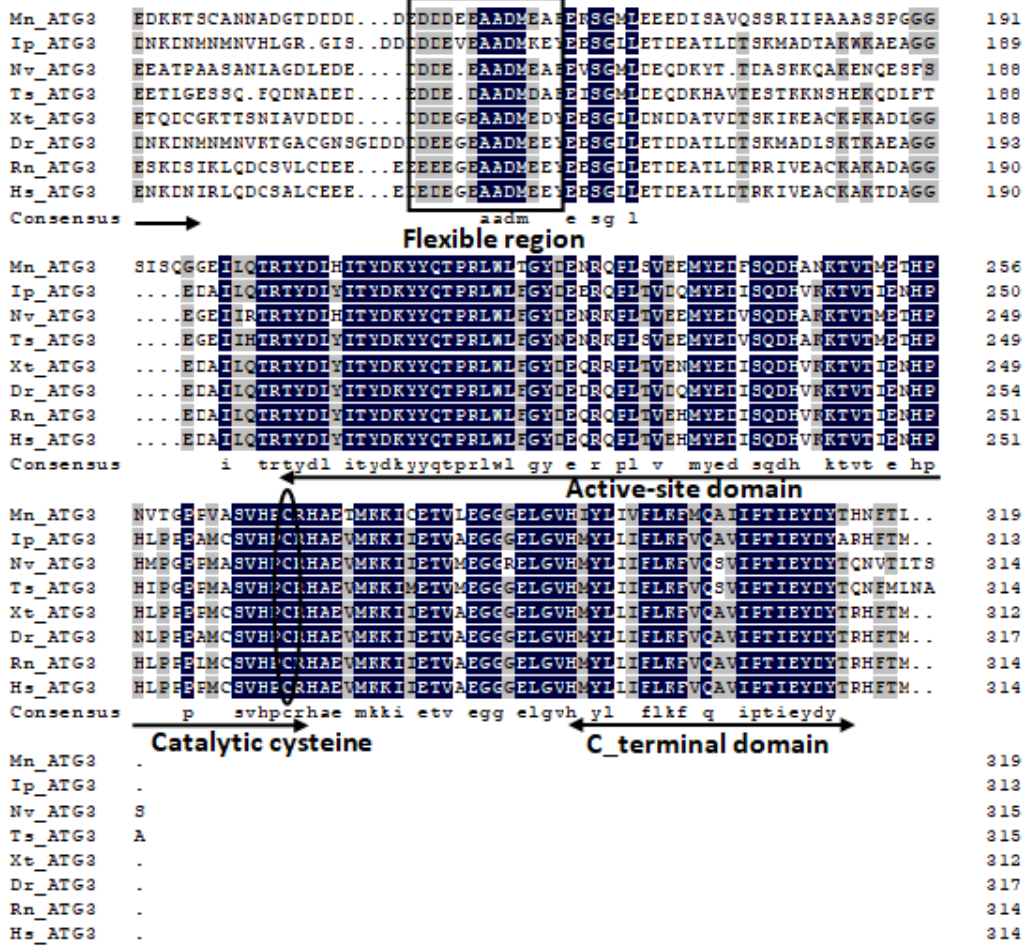
Figure A1. Multiple amino acid sequence alignment of ATG3 from Macrobrachium nipponensis and other species. The accession numbers for ATG3 from Macrobrachium nipponensis (Mn), Ictalurus punctatus (Ip), Nasonia vitripennis (Nv), Trachymyrmex septentrionalis (Ts), Xenopus tropicalis (Xt), Danio rerio (Dr), Rattus norvegicus (Rn) and Homo sapiens (Hs) are MK296399, NP_001187315.1, XP_001601099.1, XP_018342260.1, NP_001011420.1, NP_956316.1, NP_599221.1, and NP_071933.2 respectively. The arrows below the sequences indicate conserved domains (N-terminal domain, C-terminal domain and active-site domain). AA within the oval frame represents the conserved catalytic cysteine. The flexible region (FR) is boxed.